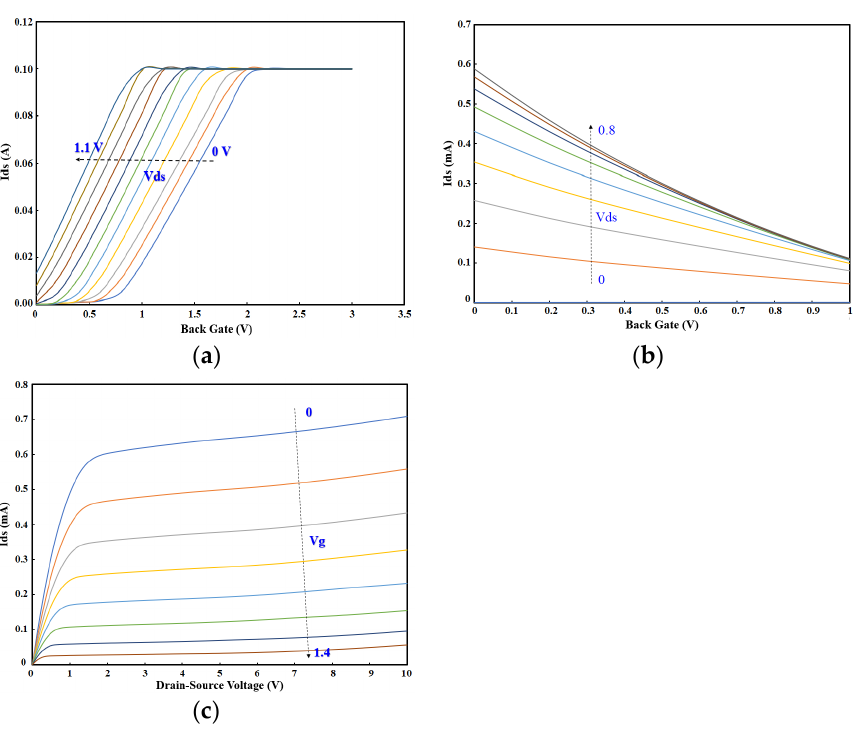
Figure 6. The current-voltage curves of the OG-JFET sensor for two bias conditions, forward and reverse. ( a ) Ids-Vgs of forwarding bias. ( b ) Ids-Vgs of reverse bias condition. ( c ) Ids-Vds curve for reverse bias condition (steps: 0.2 V).